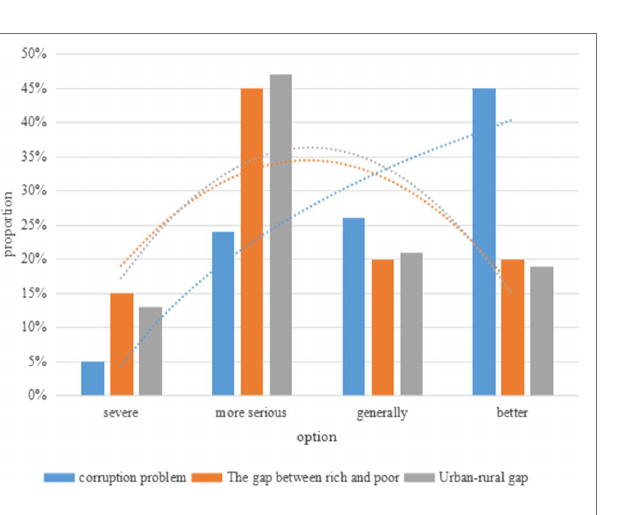
FIGURE 8 | The concerns and opinions of college students with different majors on social justice issues. (A) Concerns about social justice issues. (B) Views on social justice issues.